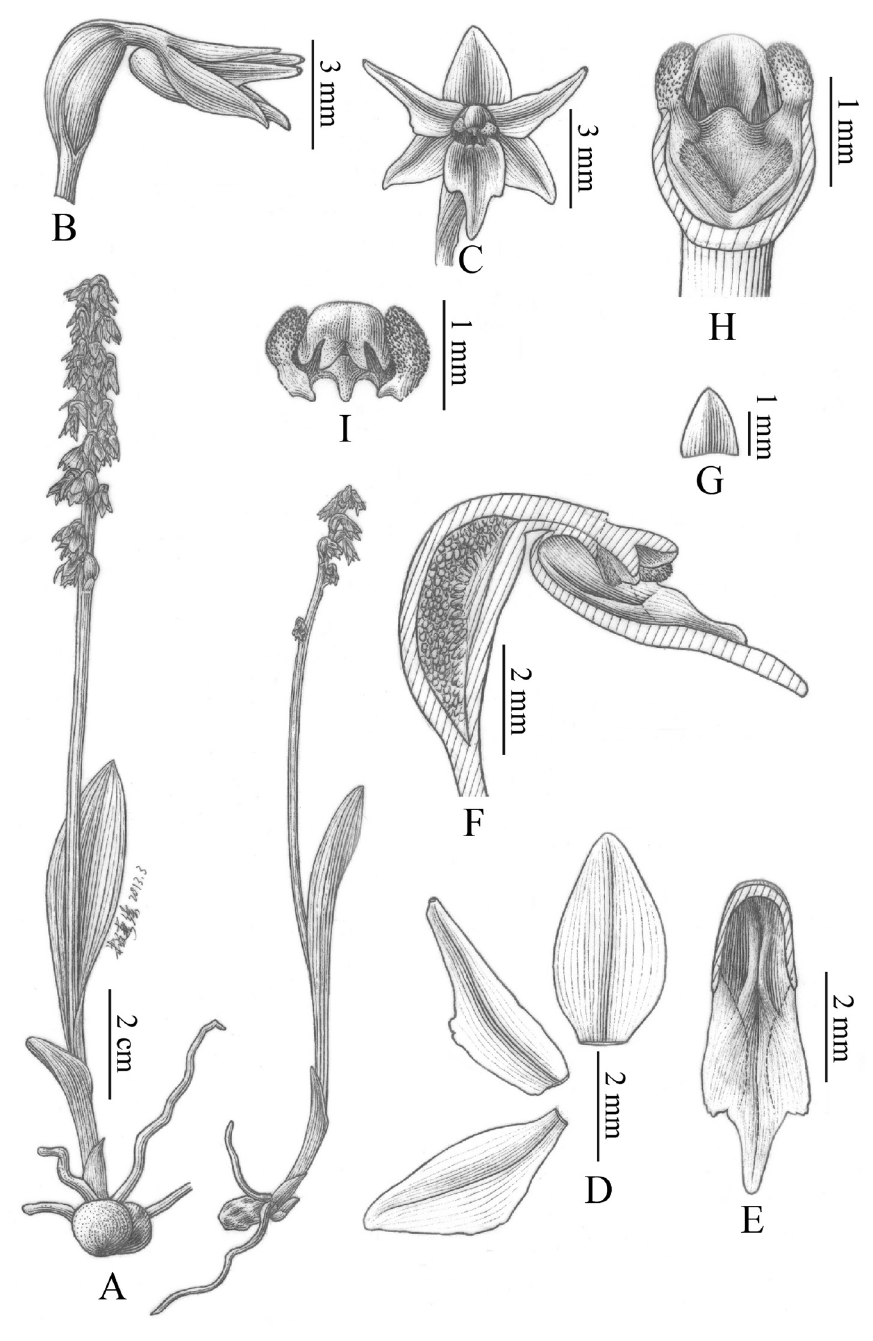
Figure 15. Herminium tibeticum . A Flowering plant B Flower (side view) C Flower spread (front view) D Dorsal sepal, lateral sepal and petal E Lip F Section of ovary with column G Floral bract H Column with stigma (front view) I Anther cap, auricles and